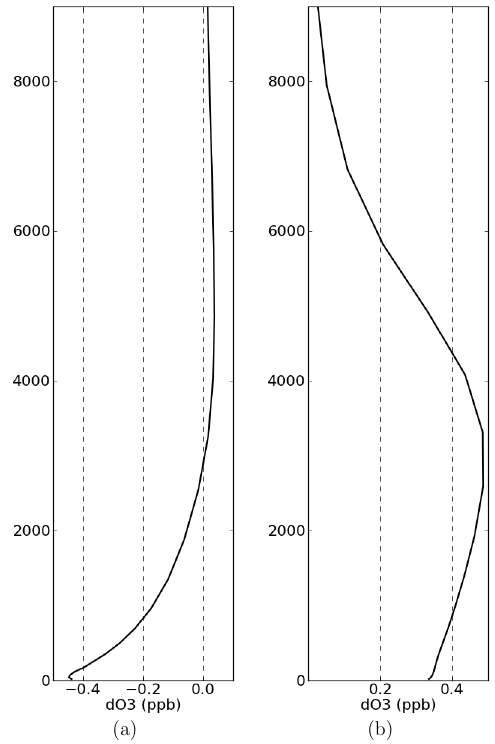
(cid:3) − (cid:2) O Figure 19. (a) (cid:2) O 3 (cid:3) as a function of the height in 3 REF NA metres above the ground level (ma.g.l), averaged for the Mediter- ranean basin (35–45 ◦ N × 5 ◦ W–35 ◦ E) for all the simulation pe- riod (6 June–15 July); (b) same as (a) but for the Saharan area (5– 30 ◦ N × 10 ◦ W–30 ◦